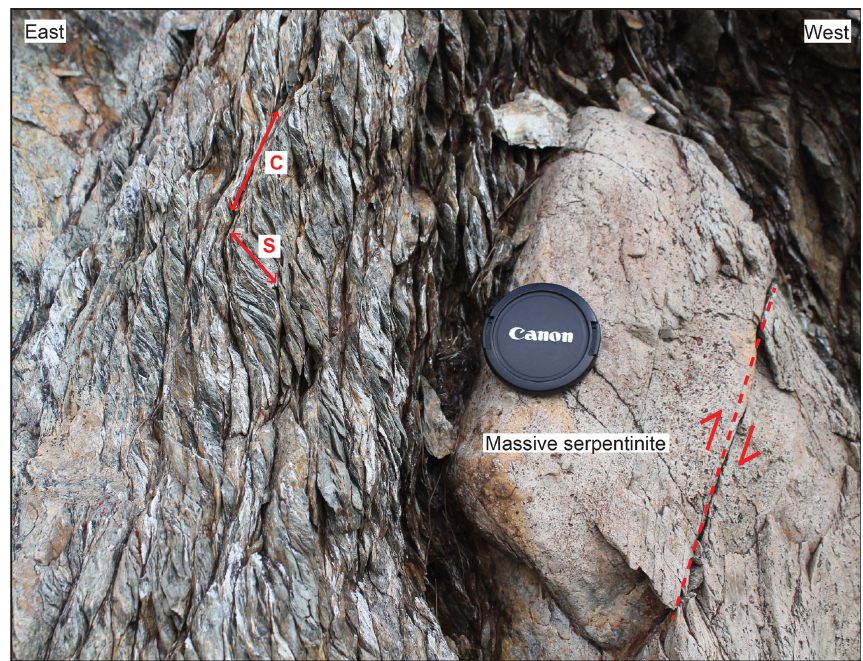
Figure 5. Photo showing well-defined S–C fabrics at Cow Saddle, wrapping around a fractured pod of massive serpentinite. Structural data from Cow Saddle are shown in Fig. 2. The asymmetry of the S–C fabric, combined with moderately to steeply plunging lineations on foliation surfaces and shear bands, suggests an east-side-up (i.e. Caples–Aspiring-side-up) shear sense. Fractures that cut through pods of massive serpentinite at this locality are subparallel to the C shear bands in the surrounding scaly matrix and have small offsets consistent with an east-side-up shear sense.